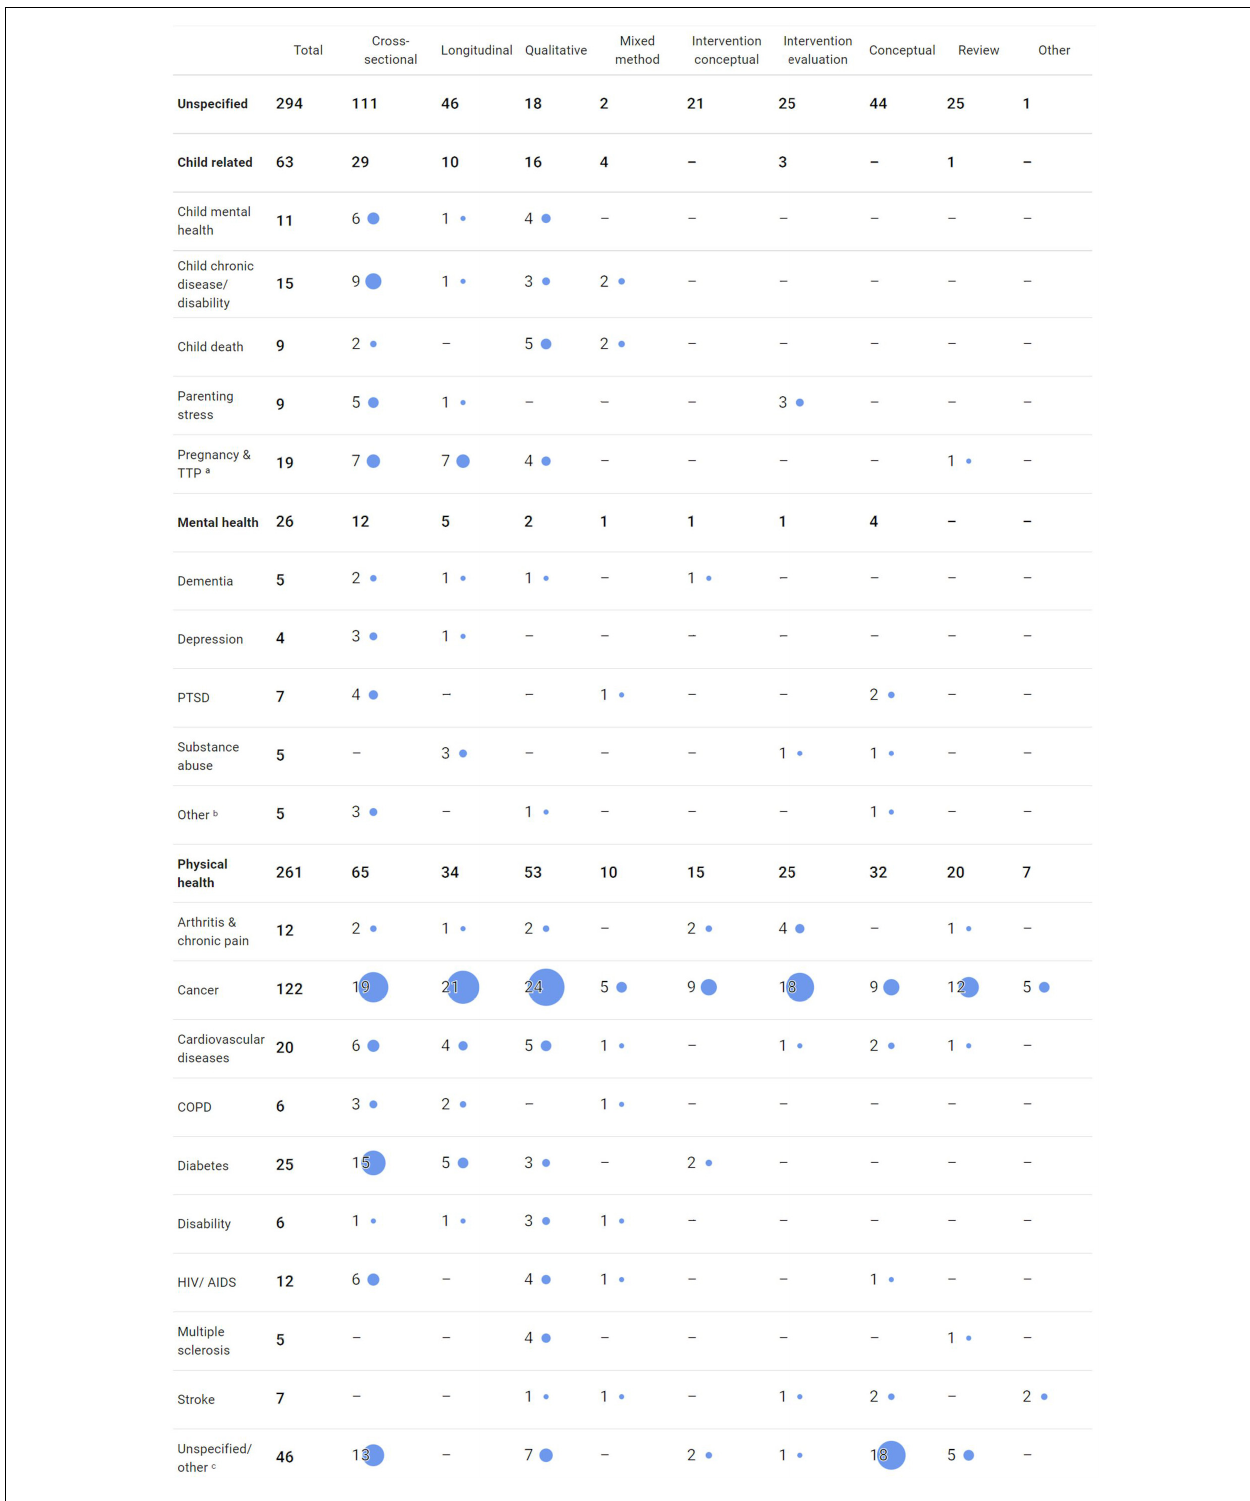
Frontiers in Psychology |